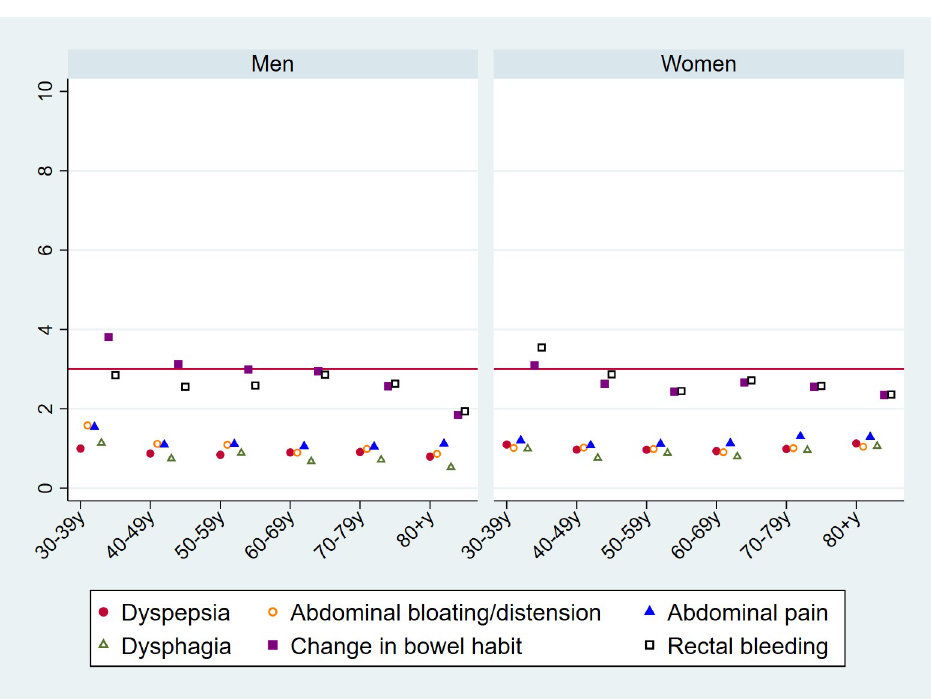
Fig 2. PPVs(%, y axis) forIBD in theyear post-presentation,per studiedsymptom, bysex (left/right panels)andage group( x axis). Theredhorizontallinerepresents the NICE3%orgreaterPPVthresholdfor urgent(two-week-wait)referral for suspectedcancer.Exactvaluesare providedinS1 Table.IBD,inflammatory boweldisease;PPV,positivepredictivevalue.